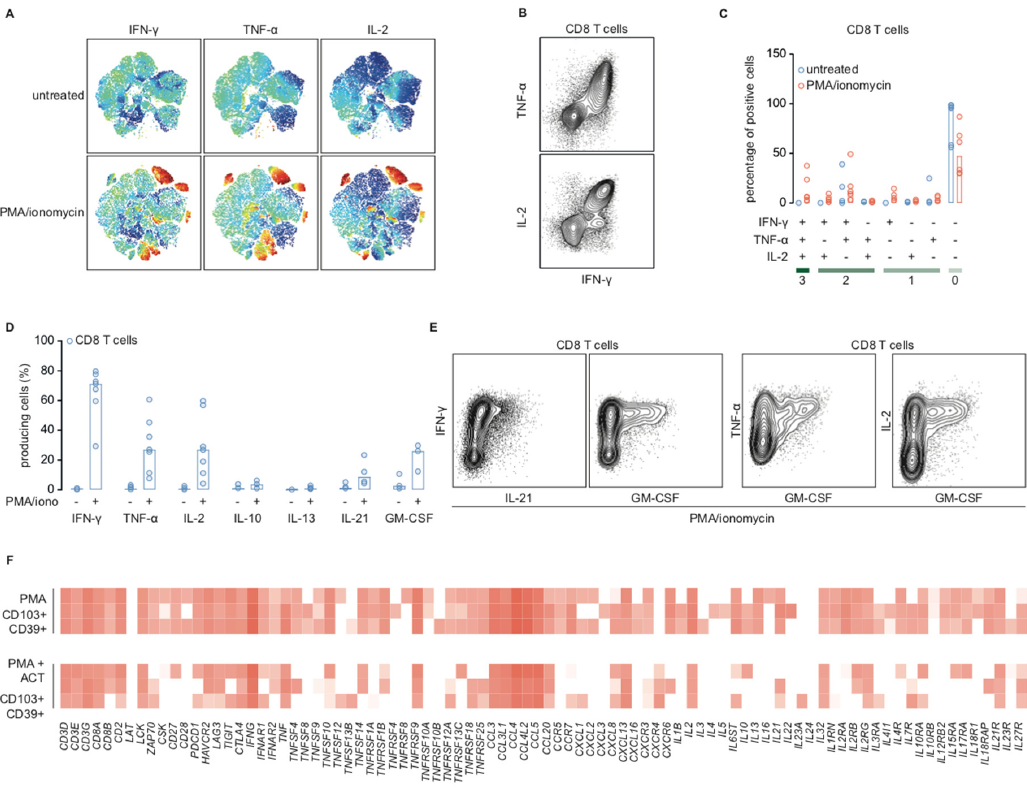
Figure 5. Activated CD8 + T cells are polyfunctional T cells that are responsive to (re)activation. ( A ) t-stochastic neighbor embedding plots of flow cytometry data of three endometrial tumor digests stained for CD3, CD8, IFN- γ , TNF- α , IL-2, and Zombie Aqua (live / dead stain). ( B ) Exemplary flow cytometry image of CD8 + T cells stained for CD3, CD8, IFN- γ , TNF- α , and IL-2. ( C ) Endometrial digests stained as described in ( B ) ( n = 6). Percentages of untreated cells (blue) or cells activated by 4-h incubation with PMA / ionomycin (red) that produce no, one, two, or three of the depicted cytokines. Bars depict the median. ( D ) Endometrial cancer digests ( n = 7) stained for CD3, CD8, IFN- γ , TNF- α , IL-2, and Zombie Aqua; 4 of these digests were additionally stained for IL-13 and IL-21, and 3 digests for IL-10 and GM-CSF. Percentages of untreated CD8 + TIL and CD8 + TIL activated by 4-h incubation with PMA / ionomycin positive for either of the depicted cytokines. Bars depict the median. ( E ) Exemplary flow cytometry images of CD8 + TIL stimulated for 4 h with PMA / ionomycin as depicted in D. ( F ) Heatmap of a customized set of T cell markers of library size-normalized, log2-transformed counts of PMA / ionomycin- and PMA / ionomycin + actinomycin D-treated CD39 + CD103 + T RM cells. 2.5. T RM -Genes and PMA-Responsive Genes are Associated with Response to Immune Checkpoint Blockade